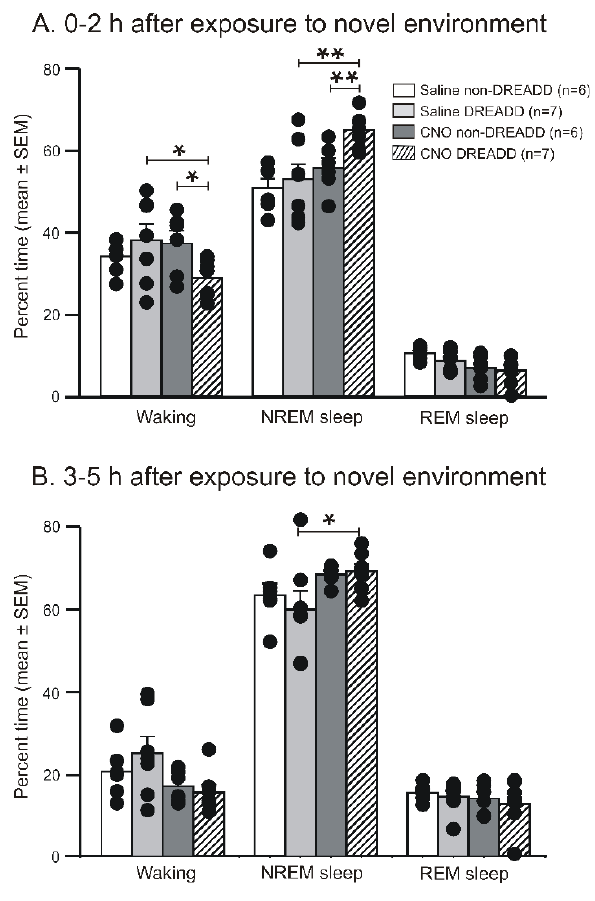
Figure 5. Effects of the chemo-activation of VLPO > PF-HA PRJ neurons on sleep–waking after exposure to the novel environment during the light phase. The percent of time spent by the individual non-DREADD and DREADD rats (filled circles) and as respective groups (mean ± SEM; bars) in waking, nonREM sleep, and REM sleep during the five h (divided into first two, ( A ), and last three h, ( B )) of recording after exposure to the novel environment plus saline and 1 mg/kg of CNO treatments. The CNO-treated DREADD rats spent significantly less time in waking and more time in nonREM sleep after exposure to the novel environment than the non-DREADD and saline control groups. * p < 0.05; ** p < 0.01 of significance (paired t -test for within-group and t -test for between-groups